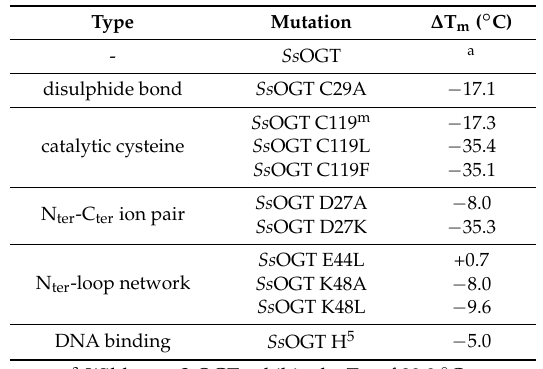
Table 2. Analysis of the thermal stability of Ss OGT and related mutants, by using Differential Scanning Fluorimetry. Ss OGT C119 m is the Ss OGT protein methylated by incubation in the presence of O 6 -methyl-guanine; Ss OGT H 5 is a mutant carrying five mutations in the HTH domain (data from